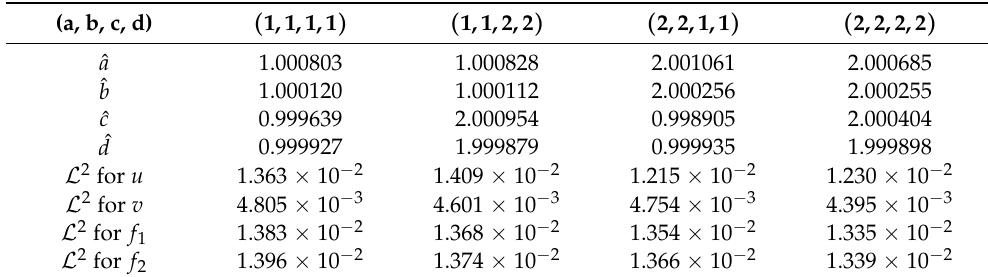
Table 6. A system of partial differential equations: estimated values of (a, b, c, d) and the relative error L 2 for u , v , f 1 and f 2 , where N u (1, 1, 1, 1), (1, 1, 2, 2), (2, 2, 1, 1) and (2, 2, 2, 2), in turn. (a, b, c,